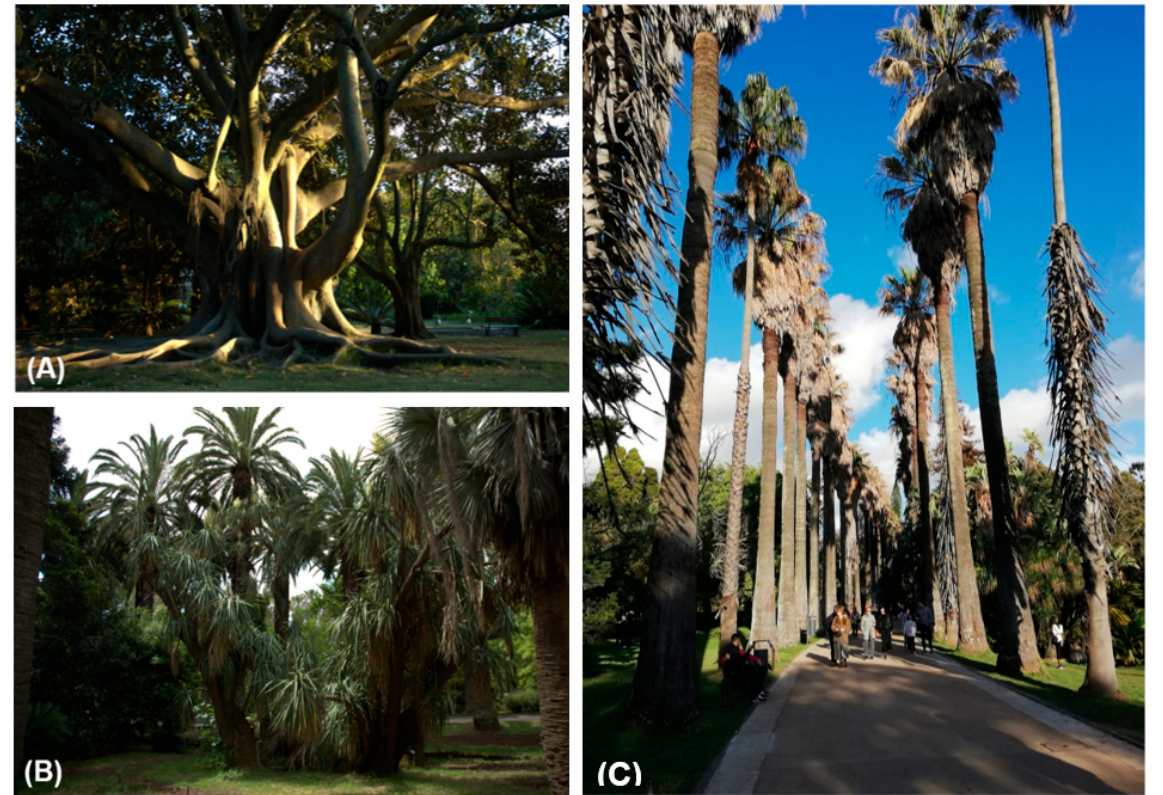
Figure 8. The iconic specimens of JBT: ( A ) Ficus macrophylla , one of the most exuberant specimens in the garden and in Europe; ( B ) Yucca gigantea , one of the JBT oldest specimens; and ( C ) the main avenue flanked by Washingtonia robusta and Washingtonia filifera , inspired by the Botanical Garden of Rio de Janeiro (Photos A and B : Duarte; Photo C : Cunha).